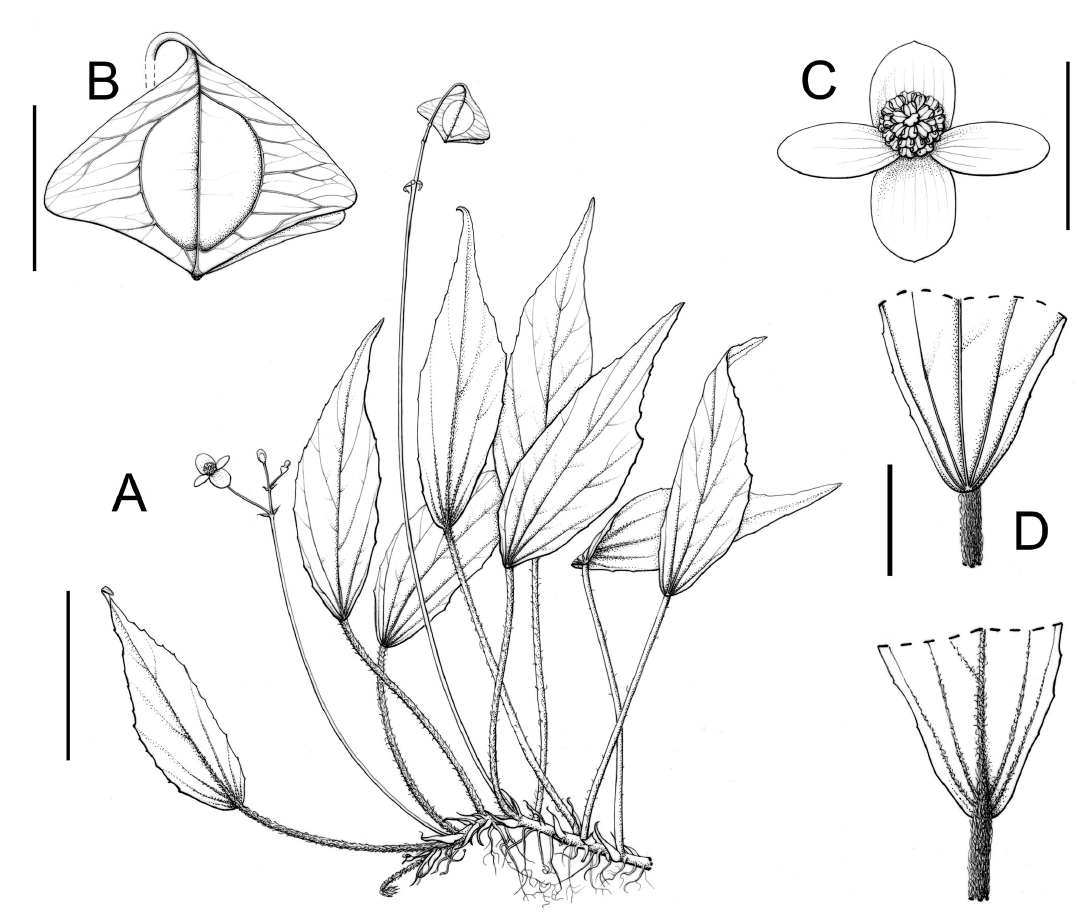
Fig. 13. Begonia lilliputana M.Hughes sp. nov. A . Habit. B . Mature fruit. C . Male flower. D . Leaf base upper (top) and lower (bottom) surface. All drawn from the holotype [ Argent 9938 (A)] by Claire Banks. Scale bars: A = 2 cm; B–D = 5